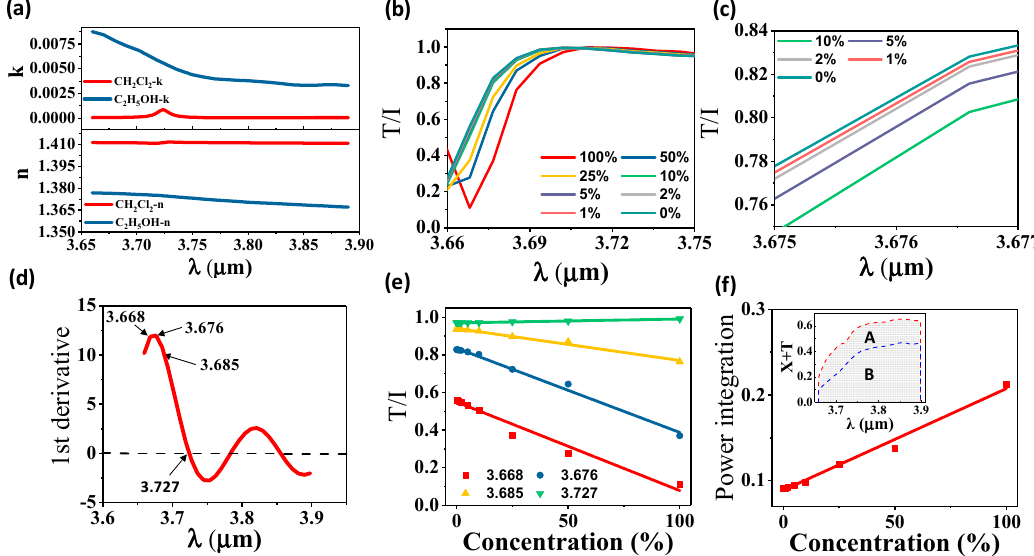
Figure 6. Simulated sensing results of CH 2 Cl 2 detection in C 2 H 5 OH using 3D FDTD simulation. ( a ) Wavelength dependent RI of CH 2 Cl 2 and C 2 H 5 OH adopted from [65]. The upper and lower panel show the imaginary part and real part respectively. ( b ) Self-normalized transmitted power (T/I) spectrum in different CH 2 Cl 2 concentration. ( c ) Zoom-in self-normalized transmitted power (T/I) for low CH 2 Cl 2 concentration sensing. ( d ) The first derivative derived from 0% CH 2 Cl 2 curve in ( b ). ( e ) The self-normalized transmitted power (T/I) versus CH 2 Cl 2 concentration at different wavelengths. The sensitivities can be extracted from the slope of the fitted linear curves. ( f ) Normalized total integrated output power (X + T) versus concentration. The slope shows the sensitivity. Inset: Spectrum of X + T. Area B is the power integration for pure C 2 H 5 OH while Area A + B is the power integration for pure CH 2 Cl 2 .